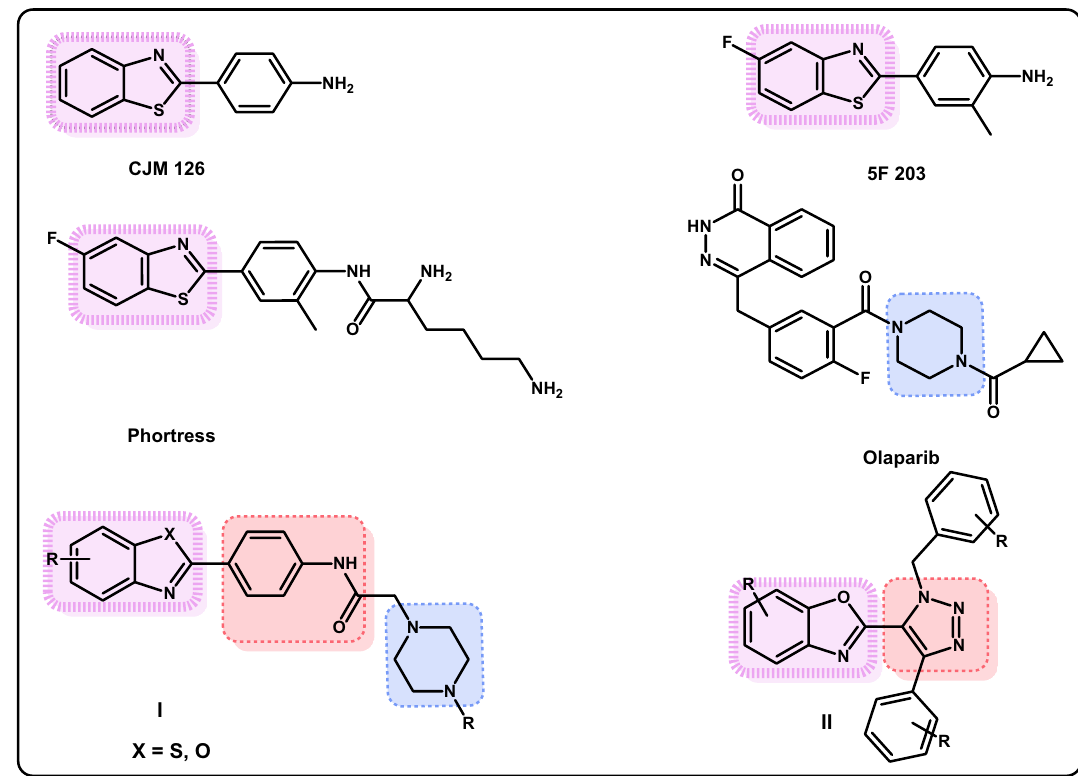
Figure 1. Chemical structures of some reported anticancer